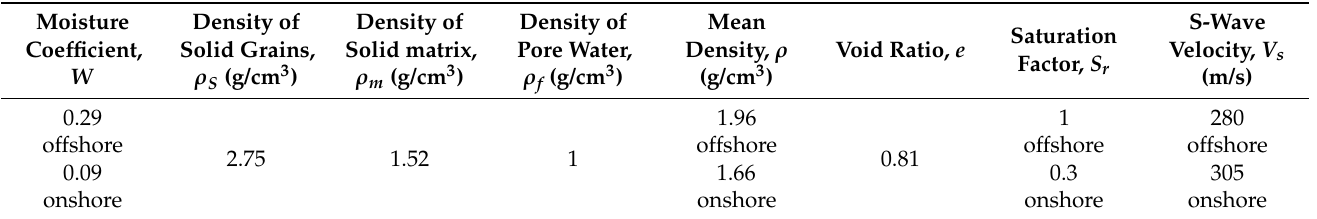
Figure 6. Synthetic profiles of cohesive and non-cohesive soils used for response modeling in onshore and offshore settings (layer thicknesses: 2.2 m for sand, 6.3 m for clayey silt, 5.5 m for soft clay; other soil parameters, see Table 2, Table 3, Table 4). Table 2. Input parameters for the case of sandy layer underlain by the flysch half-space.